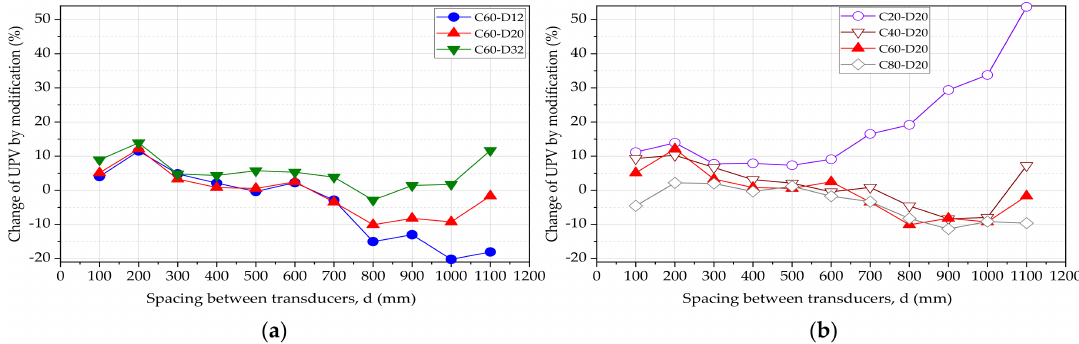
Figure 8. Change of UPV by modification ( a ) varying bar diameter ( b ) varying cover